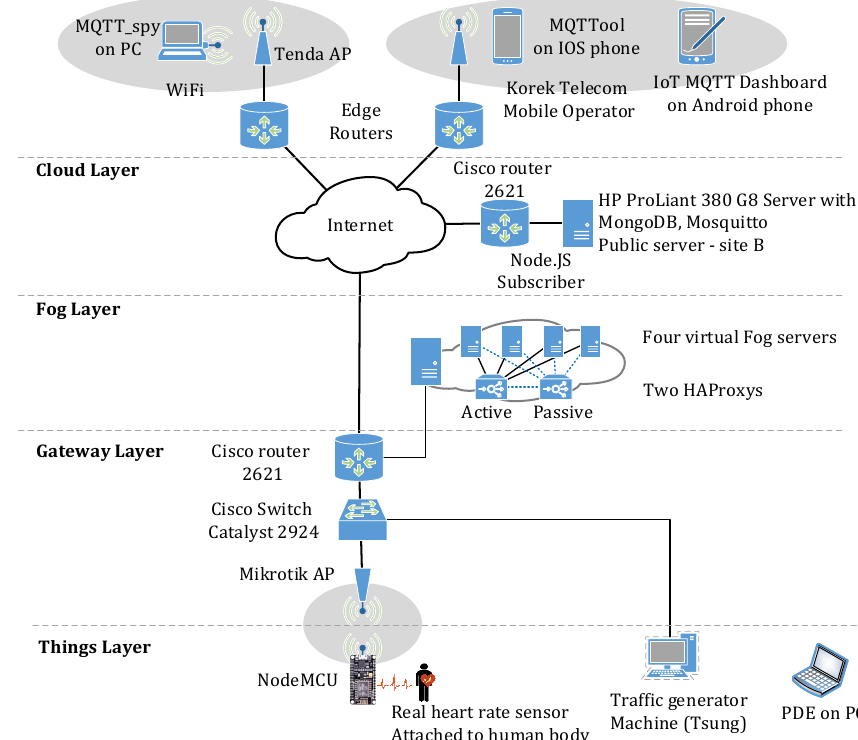
Figure 8. Proposed IoT-F2CDM-LB architecture with HAProxy load balancer